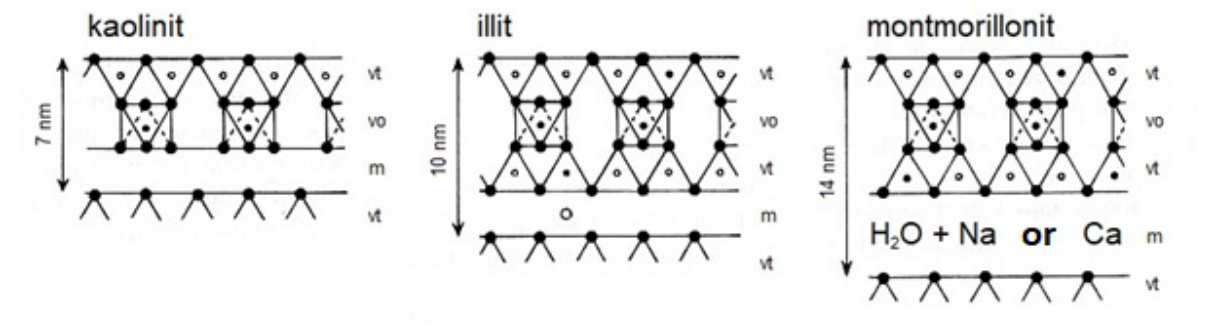
Figure 1. Structure of clay